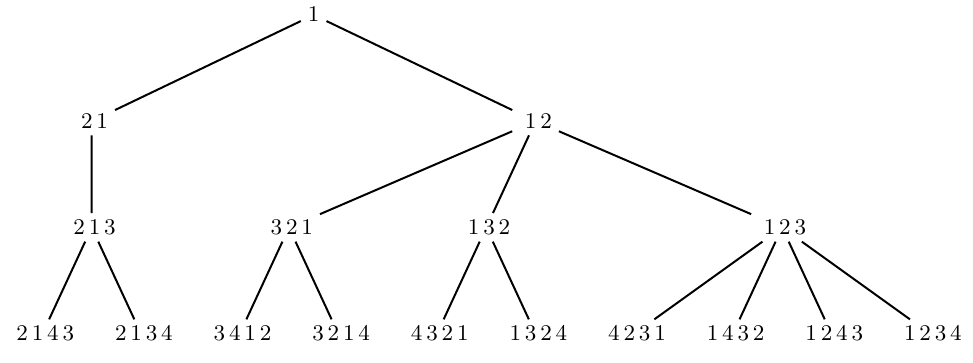
Fig. 3: The first four levels of the generating tree for involutions by fixed